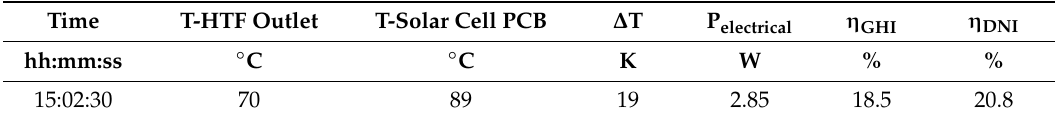
Table 5. Essential results of the measurement. T-HTF Outlet is the heat transfer fluid outlet temperature and T-Solar Cell PCB is the temperature on the bottom side of the PCB.